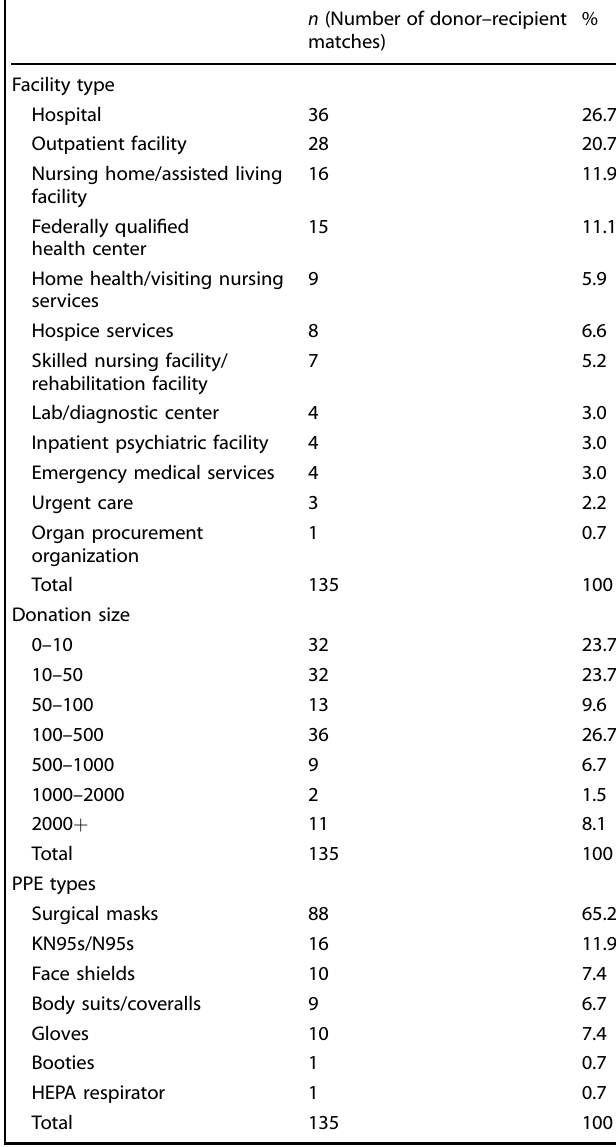
Table 1. Match characteristics.